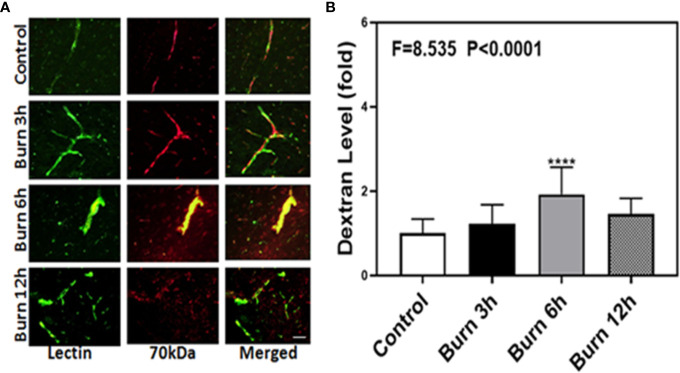
Burn increases blood–brain barrier permeability of 70-kDa dextran in mice. (A). Immunostaining of blood vessels (lectin, green, the first column) and dextran (70-kDa dextran, red, the second column) of the brain section following the control condition in mice (the first row), the burn in mice after 3 h (the second row), the burn in mice after 6 h (the third row), and the burn in mice after 12 h (the fourth row). The third column is the merged image of the first and second columns. The red spots (non-overlap area) in the third column indicate the dextran that is not inside the blood vessel (extravascular dextran). N = total of 90 slides from six mice in each group. Scale bar, 50 µm. (B). Spectrophotometric quantification of brain dextran shows that the burn increases extravascular 70-kDa dextran level in the mouse brain tissues as compared to that in the control condition (white bar) at 3, 6, and 12 h (black, gray, and dot bar) after burn and the highest level is at 6 h (gray bar) after burn. N = 6 in each group. (****p < 0.0001).